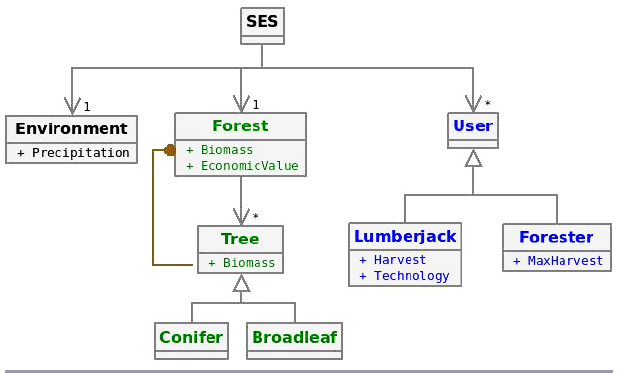
Fig. 2. A simple forestry example of a social-ecological system (SES) framework. Boxes denote concepts, black arrows pointing down denote attribution relationships, black open arrowheads pointing up denote subsumption relationships, brown links denote aggregation relationships. A 1 indicates a one-to-one attribution relationship; an asterisk indicates a one- to-many attribution relationship. Concept names are indicated in boldface in the top part of the boxes; attributed variables are listed in the bottom part of the boxes. Process relationships and outcome metrics are not